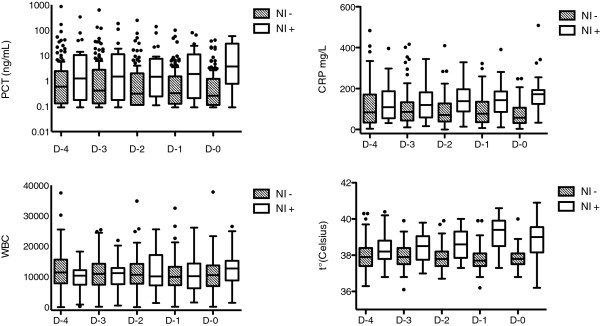
Dynamics of serum PCT and CRP concentrations, WBC and temperature in patients-acquired ICU infection and non-infected patients from D-4 to D0. NI: nosocomial Infection. Data are presented as box plot. *: p < 0.05.